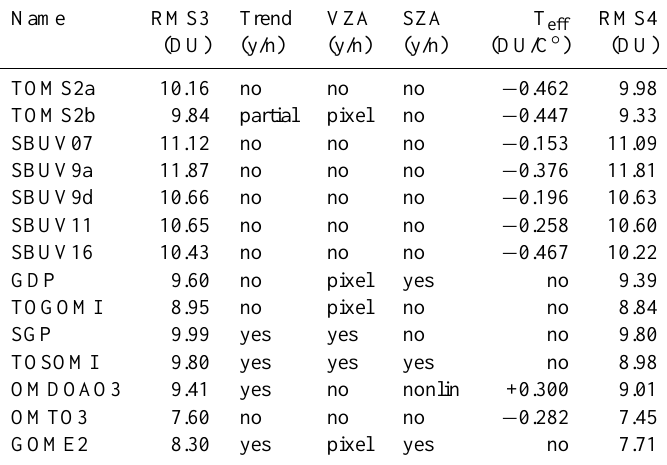
Table 3. Corrections that have been applied to the satellite datasets. The columns are: (1) Name; (2) RMS original data; (3) Trend correction; (4) View angle correction; (5) Solar angle correction; (6) Effective ozone temperature correction; (7) RMS after application of these corrections. Only one offset per satellite instrument is used